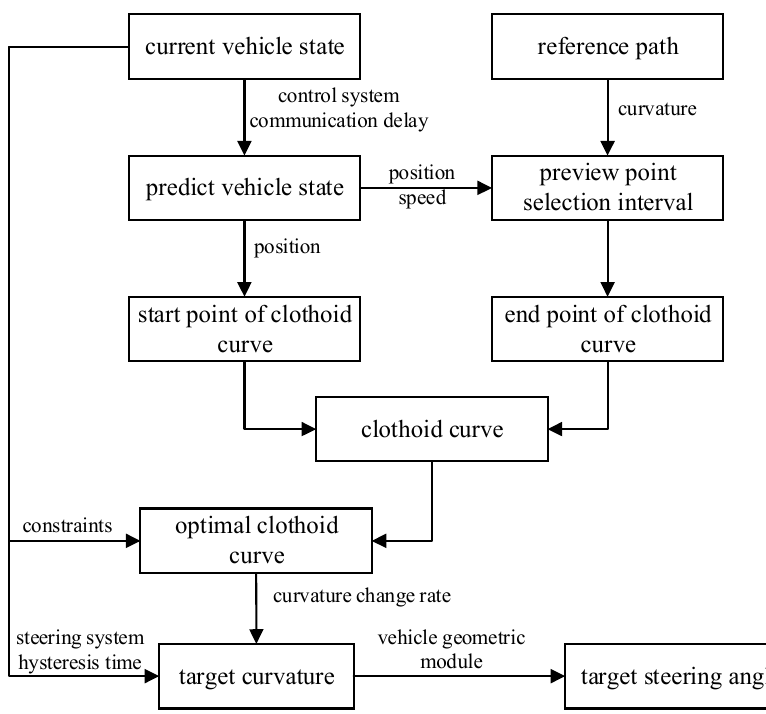
Figure 1. C lothoid-curve-based trajectory tracking control method. Figure 1. Clothoid-curve-based trajectory tracking control